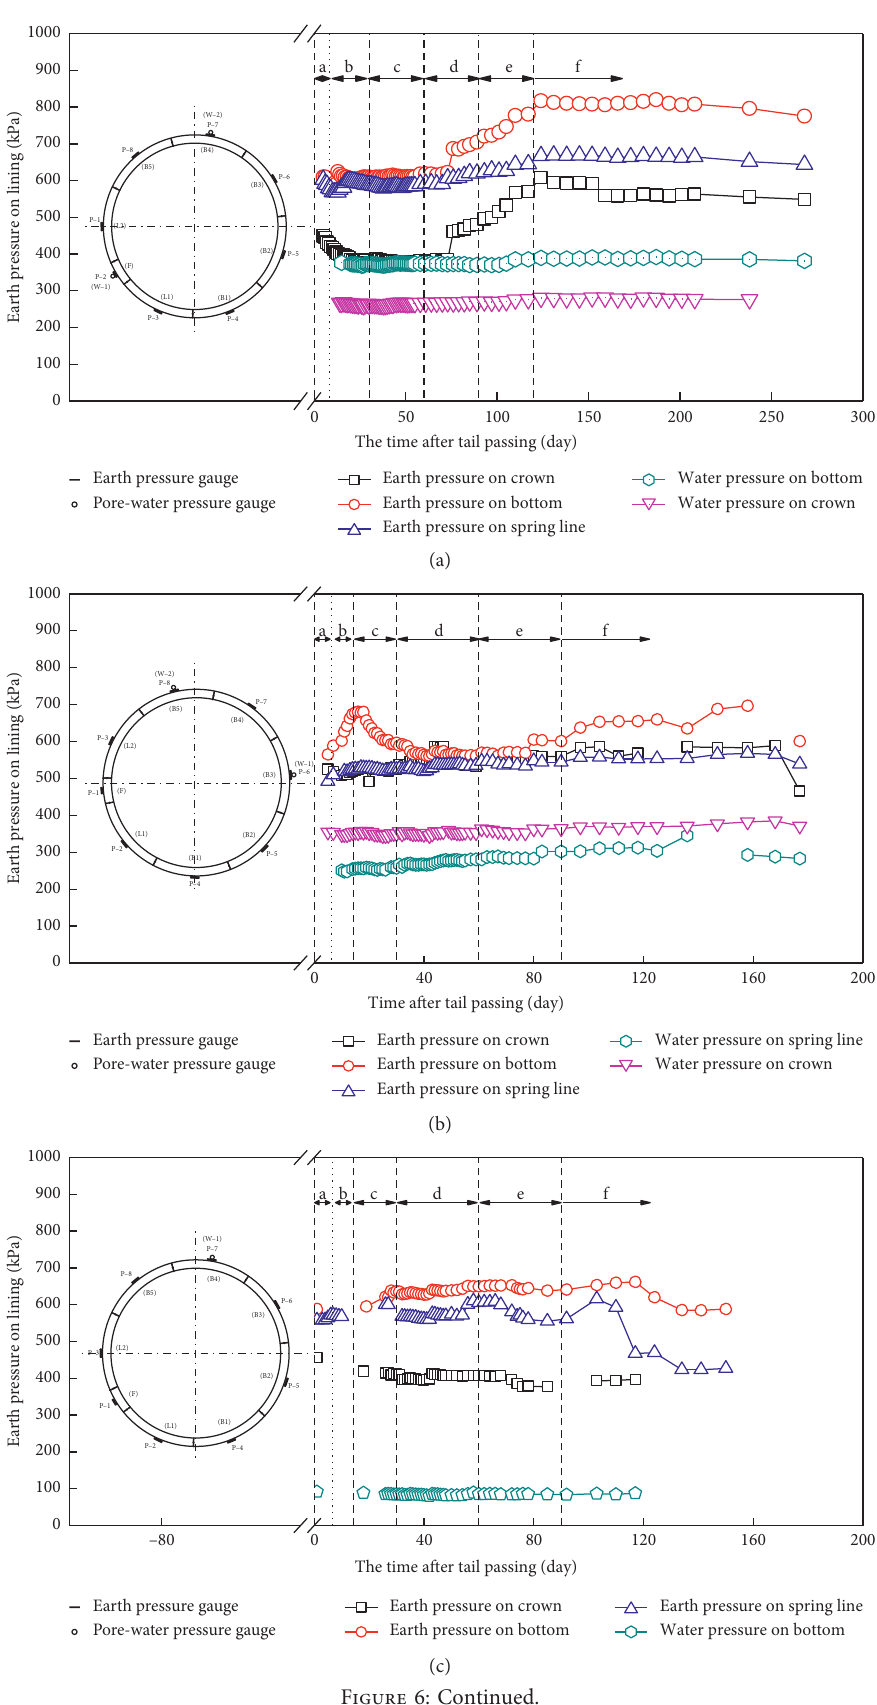
Earth pressure on crown Earth pressure on bottom (c) Figure 6: